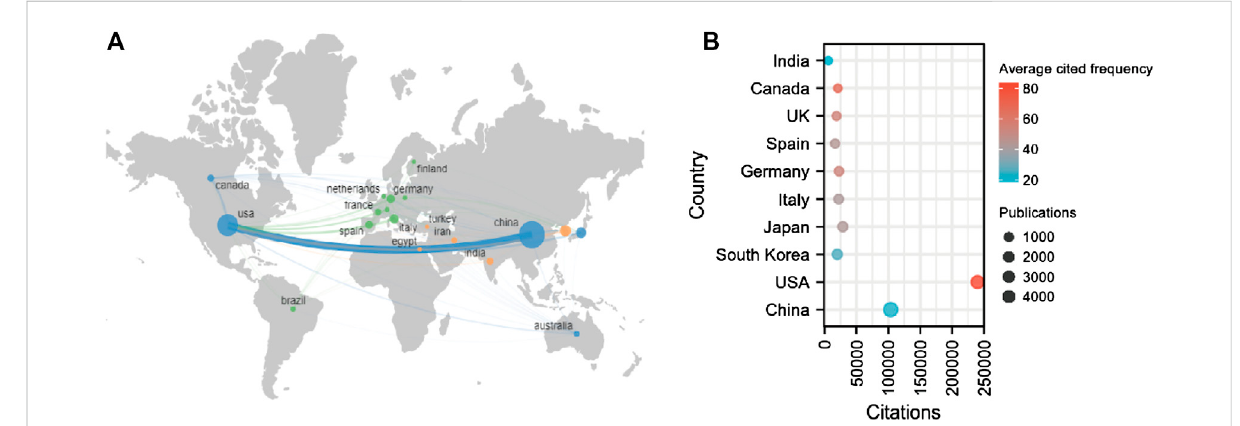
FIGURE 3 Nationalcontributionsofthesirt1study. (A) Globalgeographicdistributionandcollaborationregardingthestudyofsirt1. (B) Thetoptenhighest productive countries for the study of